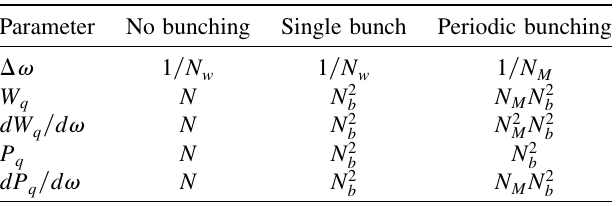
TABLE I. Scaling of the optical parameters of the radiation into a single transverse mode by prebunched e -beam radiators. Parameter No bunching Single bunch Periodic bunching